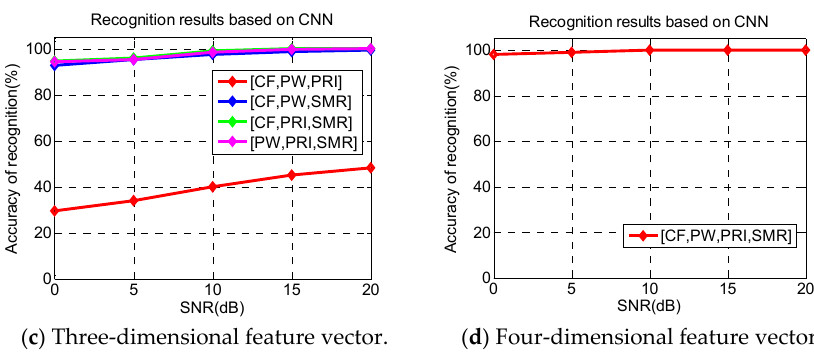
( c ) Three-dimensional feature vector. ( d ) Four-dimensional feature vector. Figure 11. Recognition results of REID based on CNN in different SNRs.